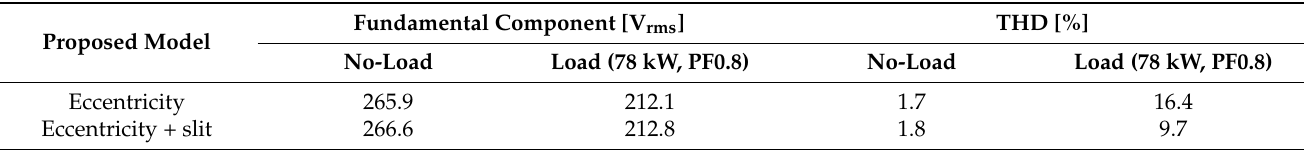
Table 3. Phase fundamental component and THD for the proposed models with an eccentricity of 10